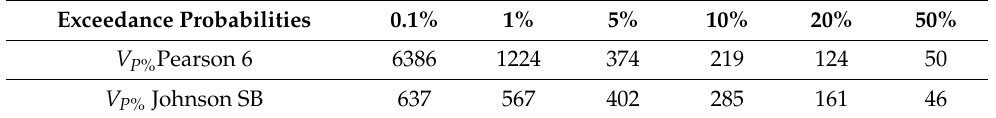
Figure 7. Deficit volumes at Lungoci gaging station (Siret River): ( a ) Pearson 6 distribution; ( b ) Johnson SB distribution. Table 2. Deficit volumes at Lungoci gaging station (mil. m 3